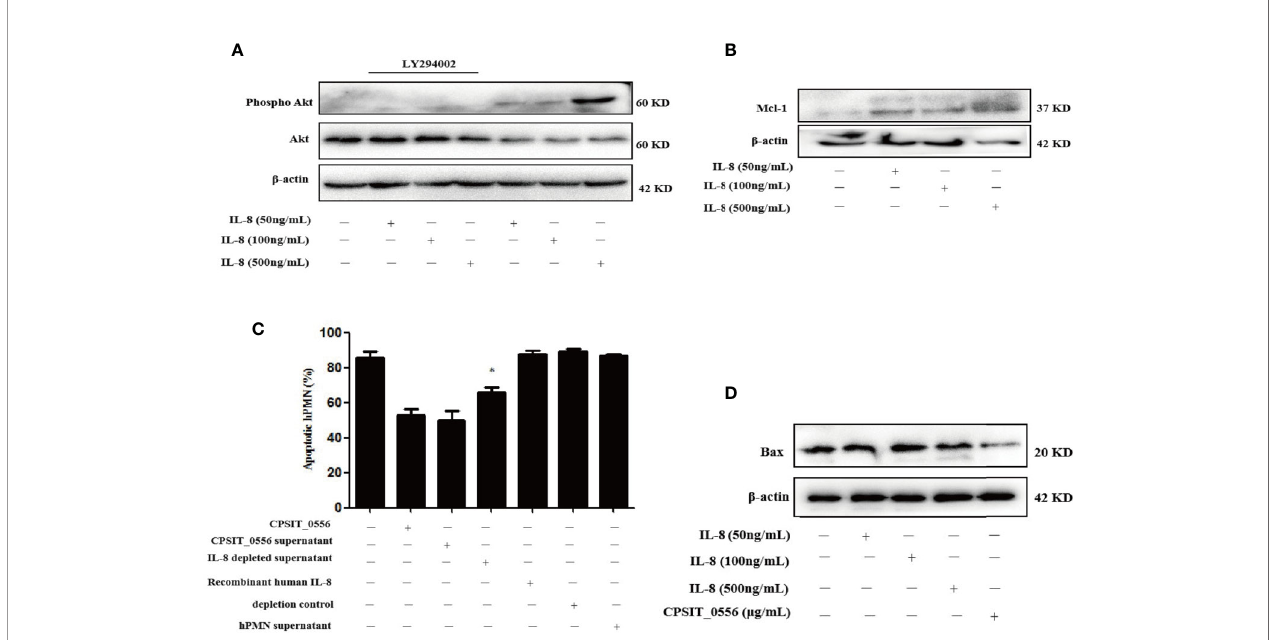
FIGURE 7 | IL-8 enhances Akt phosphorylation through the PI3K-dependent pathway as well as increases the expression of Mcl-1. (A) HPMN were pre-treated with the PI3K inhibitor LY294002 (25 m M) for 30 min., then treated with recombinant human IL-8 (50 ng/mL and 100 ng/mL and 500 ng/mL) for 30 min. Western blotting showing the phosphorylation of AKT. (B) HPMN were incubated with recombinant human IL-8 for 30 min. Western blotting showing the expression of Mcl-1, b -actin served as the loading control. The data shown are from one experiment and represent three independent experiments. (C) HPMN were cultured in medium alone, or co-cultured with CPSIT_0556, with supernatant of CPSIT_0556-hPMN, with these same supernatants depleted for IL-8 using a polyclonal anti-IL-8 mAb and protein A-agarose immunoprecipitation reagent, with recombinant human IL-8 (50 ng/mL), with a depletion control, or with supernatant from hPMN after 24 h. The apoptosis rate of hPMN was analyzed by fl ow cytometry after a 24-h culture, the data represent at least three separate experiments.* P < 0.05 compared to CPSIT_0556 supernatants prior to IL-8 depletion. (D) The hPMN were cultured in different concentrations of IL-8 for 24 h, and the expression of Bax was detected by Western blot, the data shown are from one experiment and represent three independent